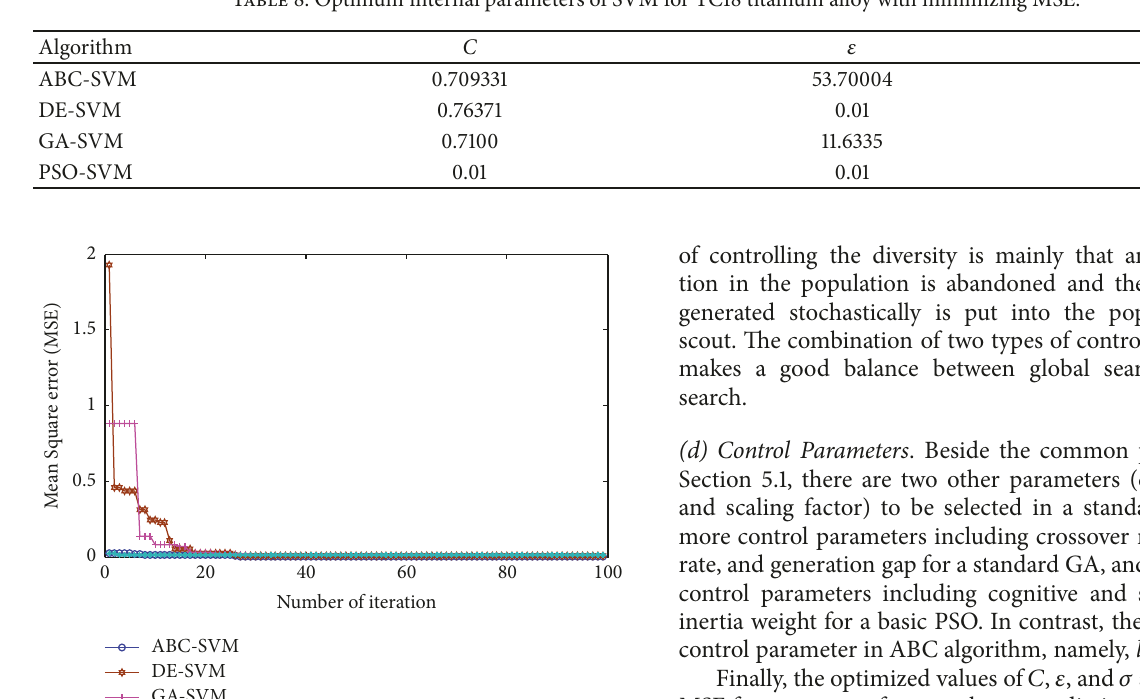
Table 8: Optimum internal parameters of SVM for TC18 titanium alloy with minimizing MSE.